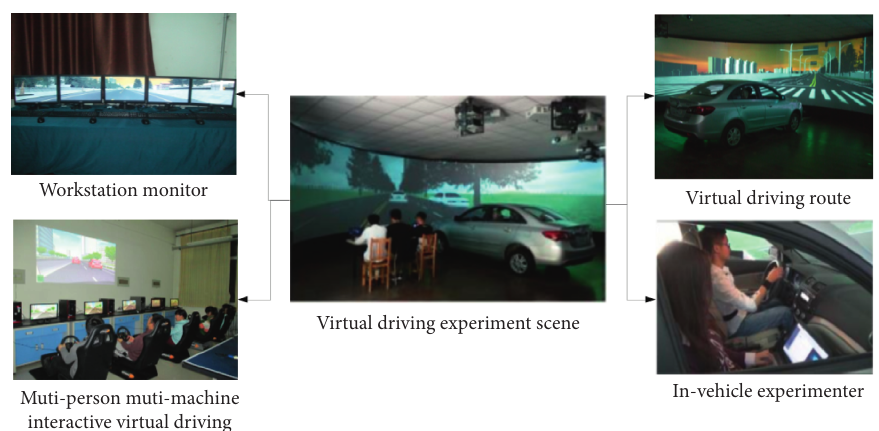
Figure 5: Virtual driving experimental